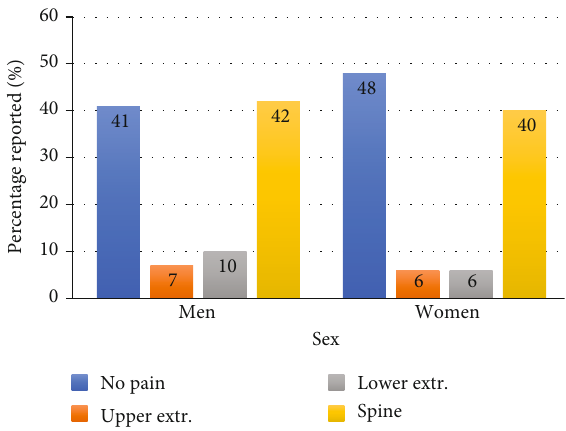
Figure 4: Location of painful sites of